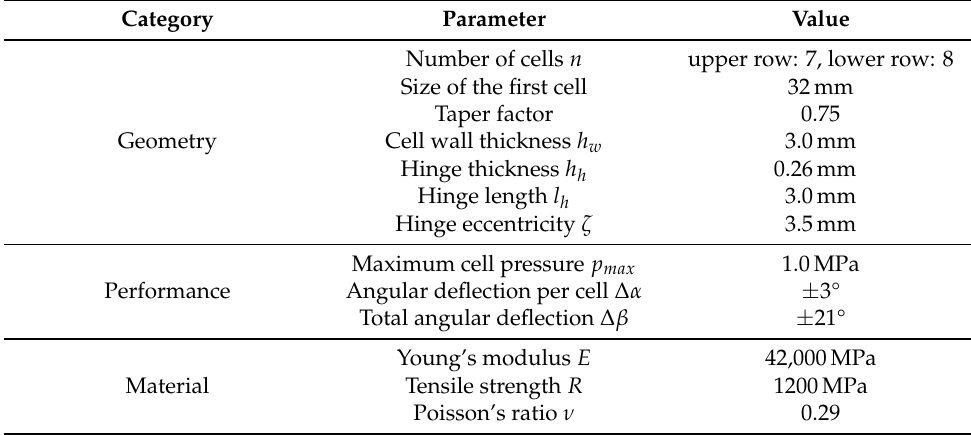
Table 1. PACS design parameters for the reduced-order truss